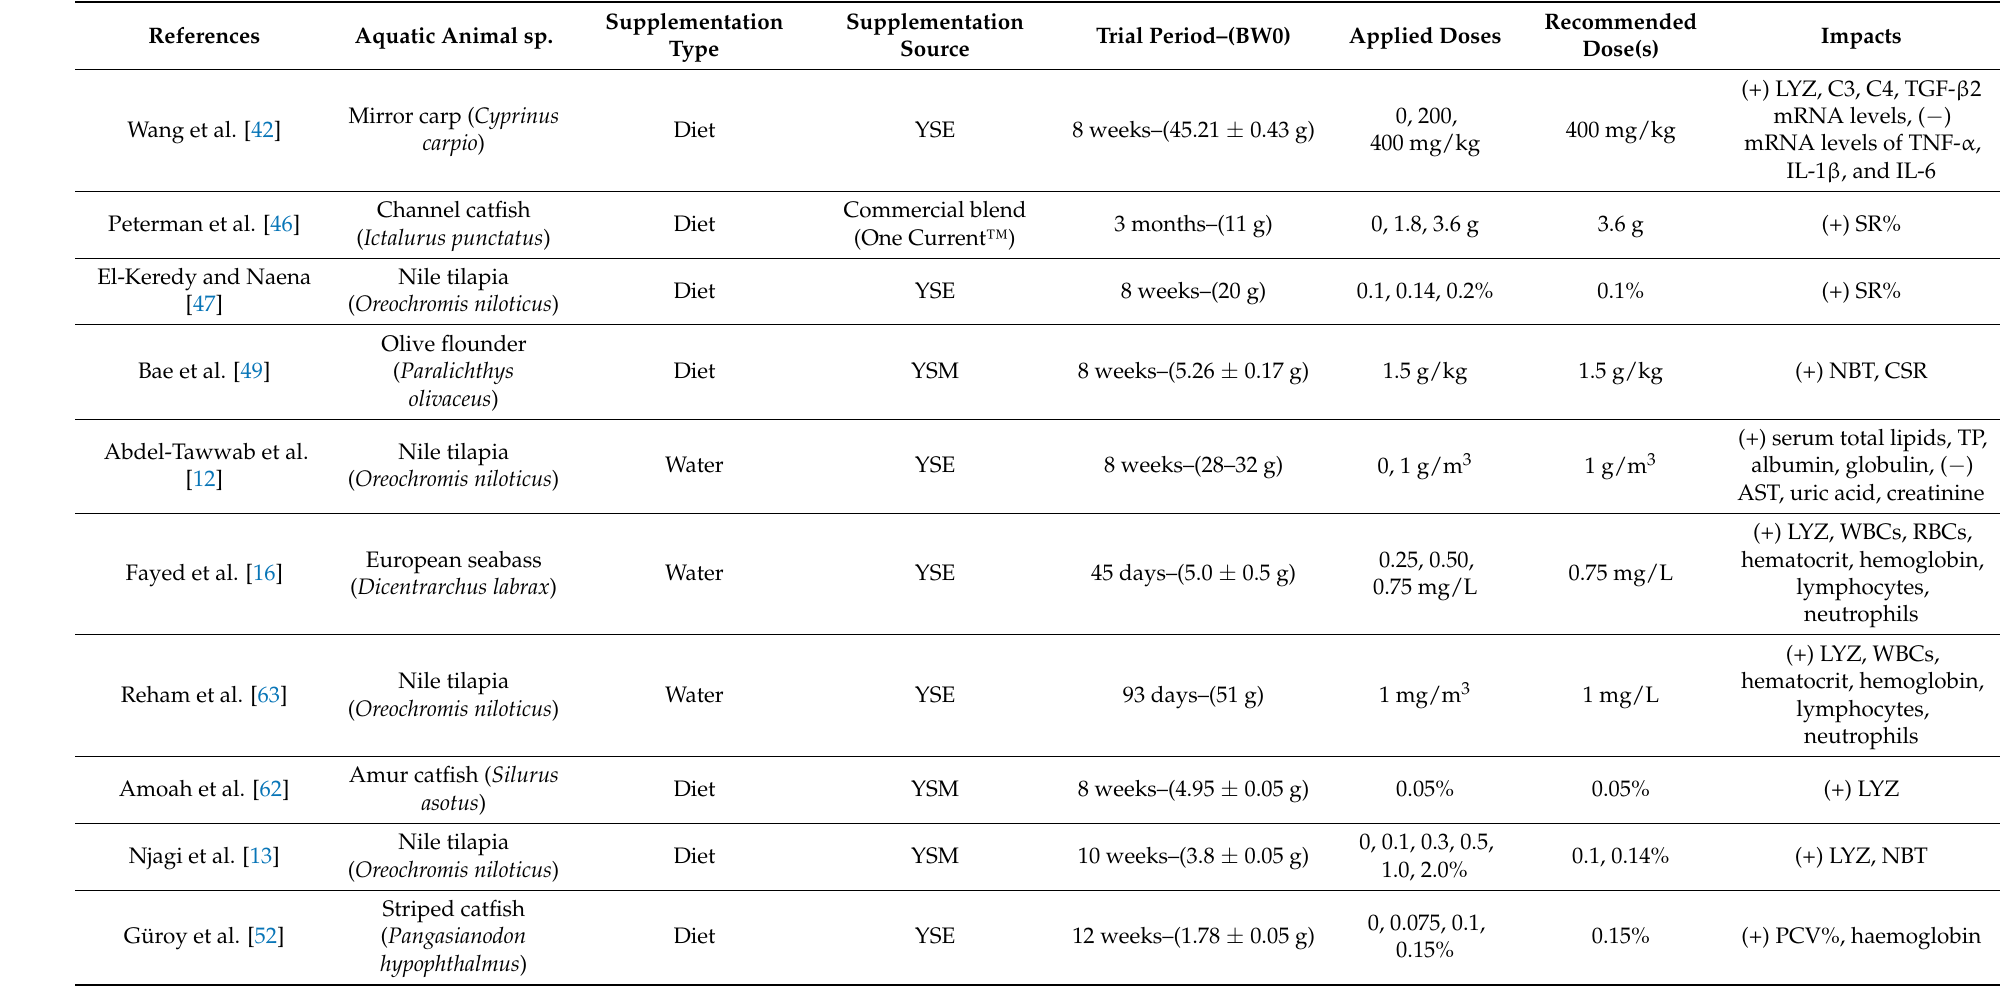
Table 2. Yucca schidigera /saponin impacts on the immune performance of aquatic